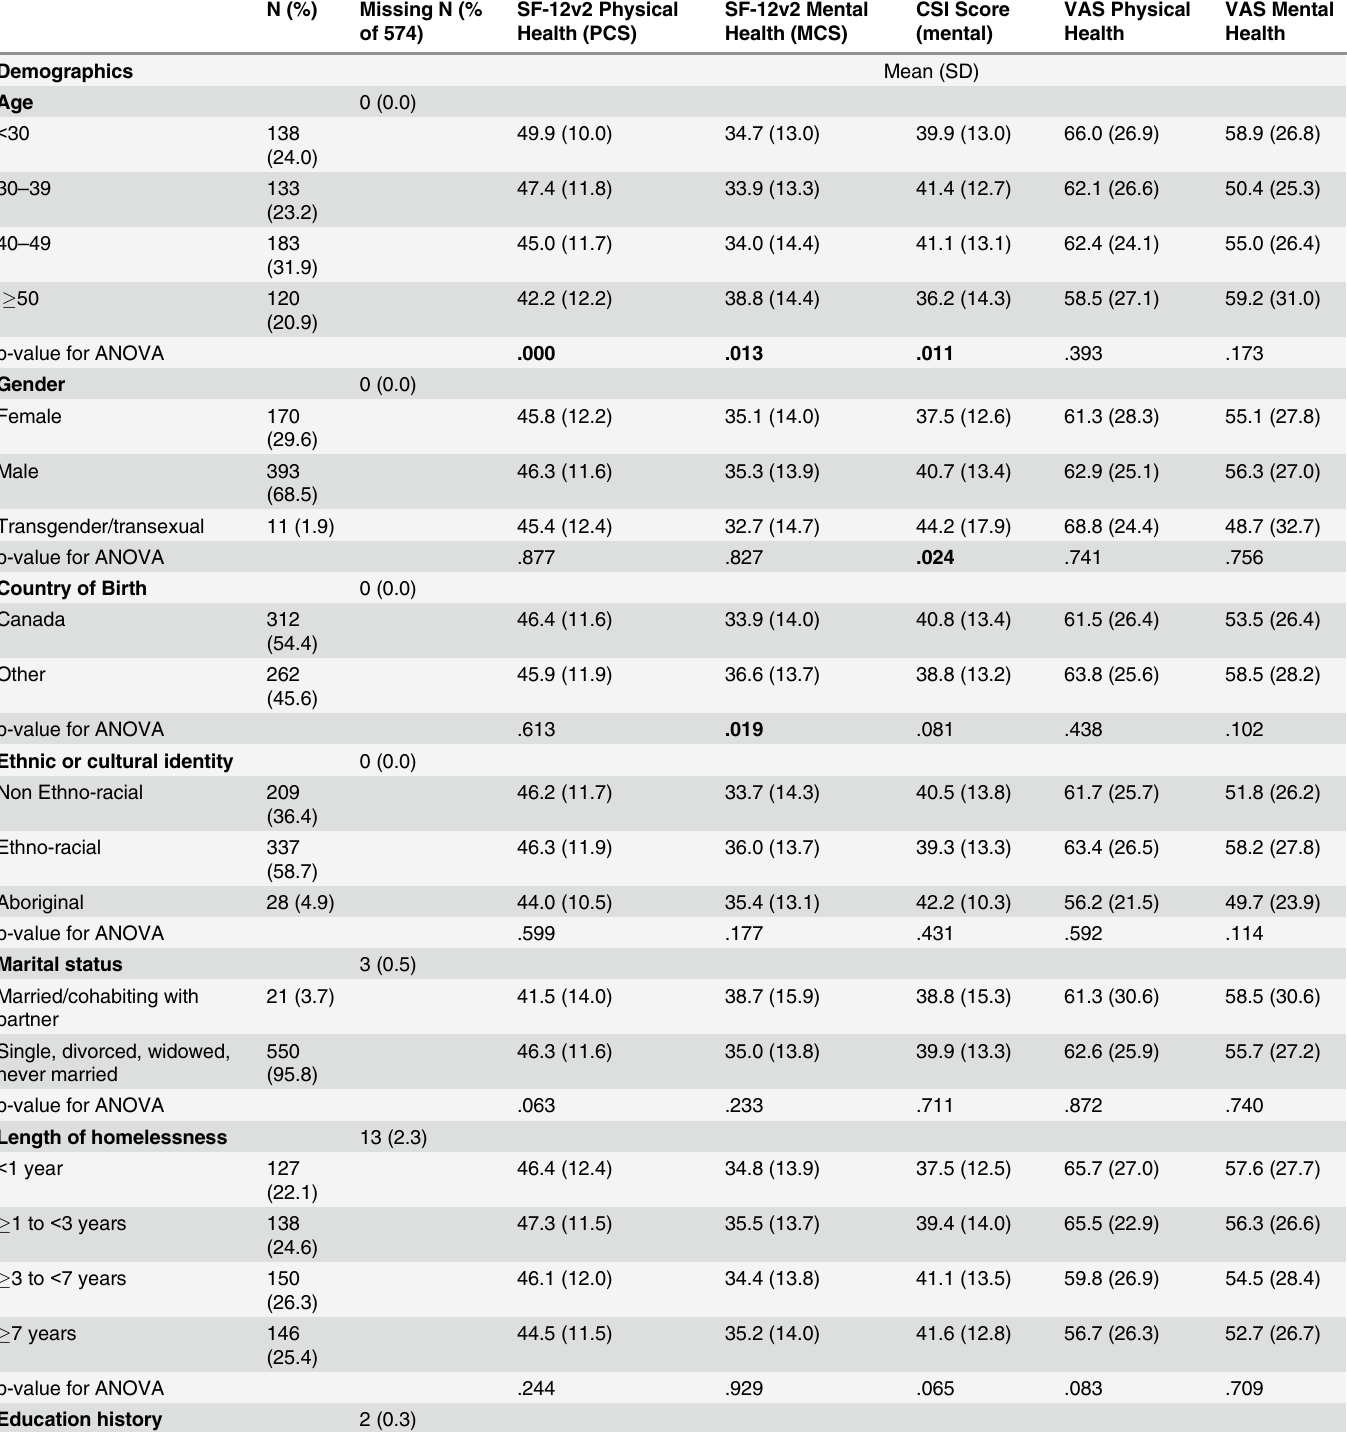
Table 3. Sample Characteristics, and the mean and standard deviations of SF-12 v.2 physical subscale, SF-12 v.2 mental subscale, CSI score, EQ- 5D physical score, and EQ-5D mental score by demographic groups (n =